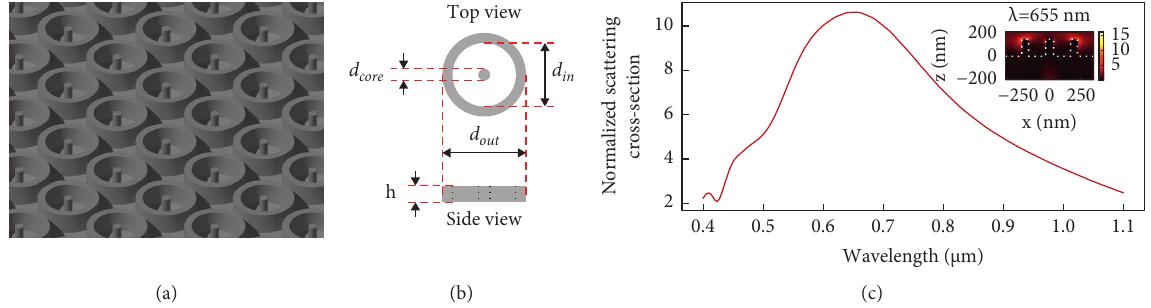
Figure 1: (a) Schematic view of the silicon subwavelength AR structure used in the simulations. (b) Main geometric parameters of the silicon subwavelength AR structure. (c) Normalized scattering cross-section (inset: normalized intensity profile at the resonance wavelength). Table 1: The main geometric parameters of the subwavelength AR structure ( μ